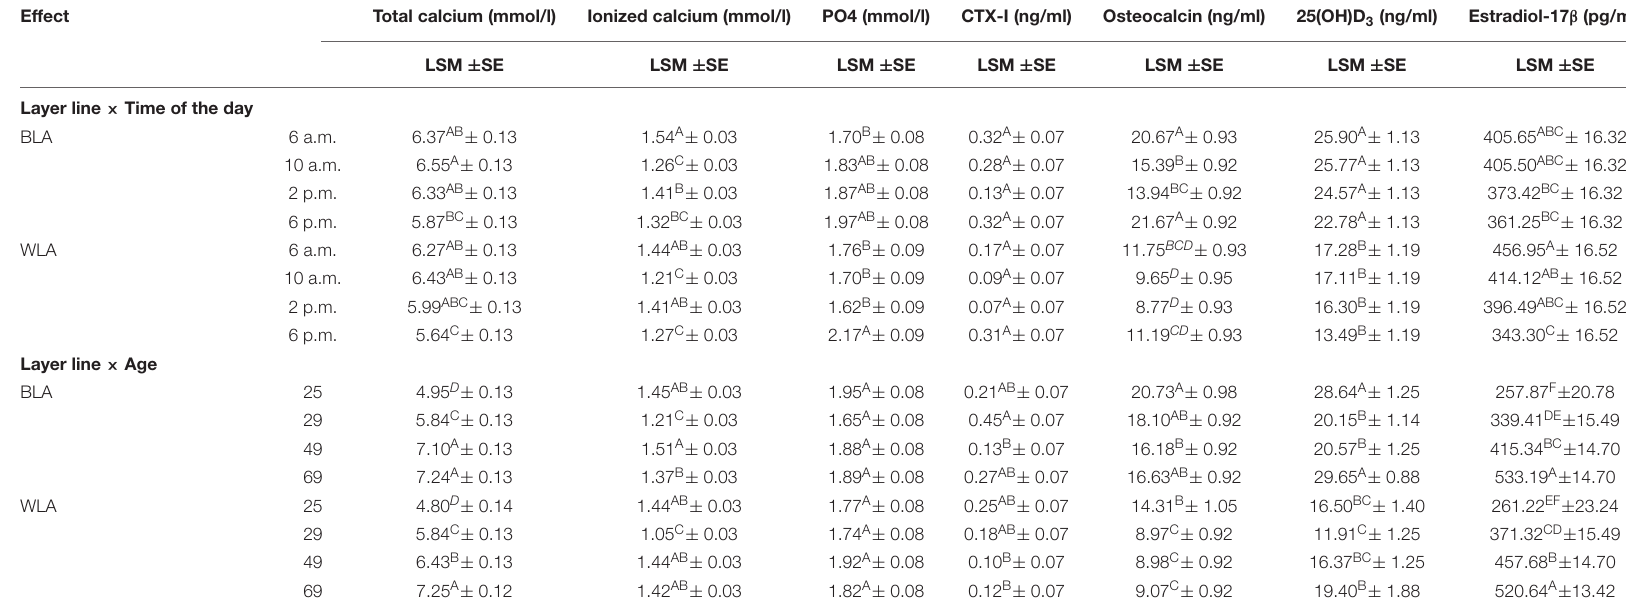
TABLE 2 | Least square means (LSM), their standard errors (SE) and significant differences between the levels of interaction effects for blood concentrations of total and ionized calcium, inorganic phosphate (PO4), the carboxyterminal crosslinked telopeptide of type I collagen (CTX-I), osteocalcin, 25-hydroxycholecalciferol (25(OH)D 3 ) and estradiol-17 β of the blood of brown-(BLA) and white-egg (WLA) laying hens examined in the 25th, 29th, 49th and 69th week of